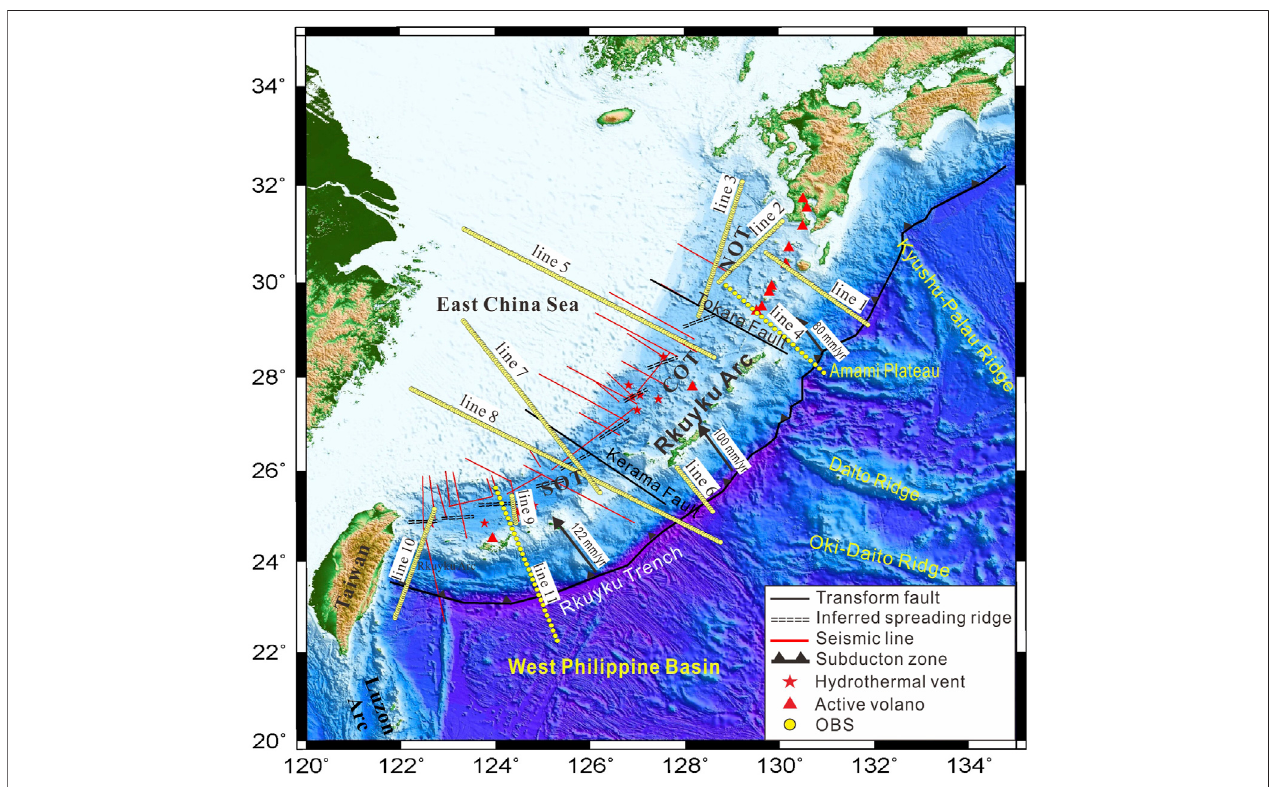
FIGURE 1 | Simpli fi ed structural map showing the tectonic setting of the Ryukyu trench-arc-basin system and its adjacent region. The base map is the ETOPO1 globalreliefgrid.NOT:northernOkinawaTrough(OT);COT:centralOT;SOT:southernOT.TheboundariesofthethreeOTsectionsaretheTokaraFaultandtheKerama Fault (Yan and Shi,